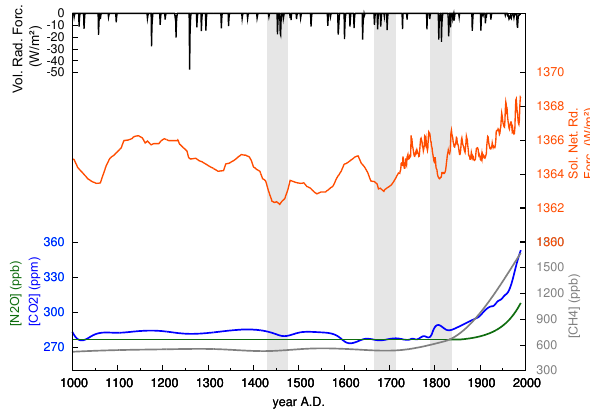
Fig. 1. Reconstruction of the forcings for the last millennium em- ployed in the simulations (Crowley, 2000). Orange line is the re- construction of the total solar irradiance. Black line shows the esti- mated reduction in the effective short wave radiative balance in the top of the atmosphere due to big volcano events. Blue, green, and grey lines show the evolution in the concentration of CO 2 , NO 2 , and CH 4 , respectively. Grey bars indicate three important periods further discussed in the sections below.